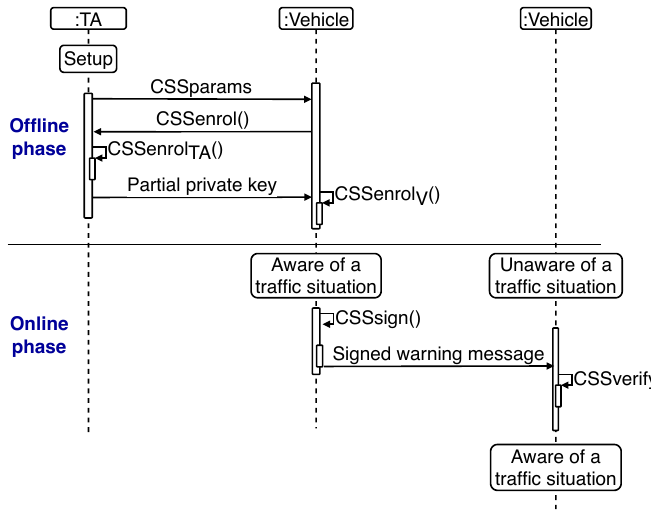
Figure 2. Sequence diagram of the certificateless signature scheme (CSS)